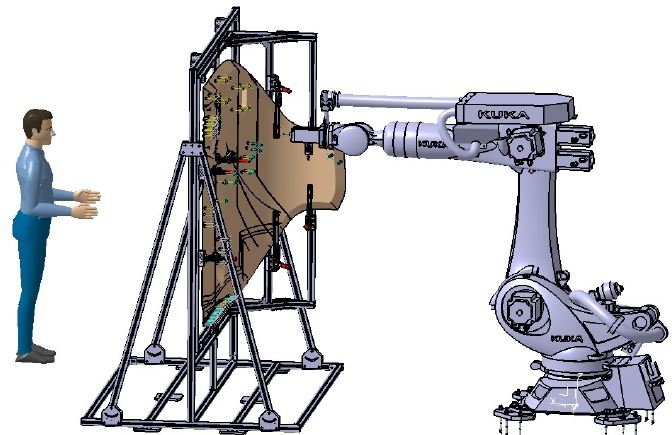
Figure 3. Drawing of the setup proposed to evaluate the case of machining and potting the 107 spots in the gear landing door by using specific end-effectors dedicated to each task, mounted on a conventional robotic